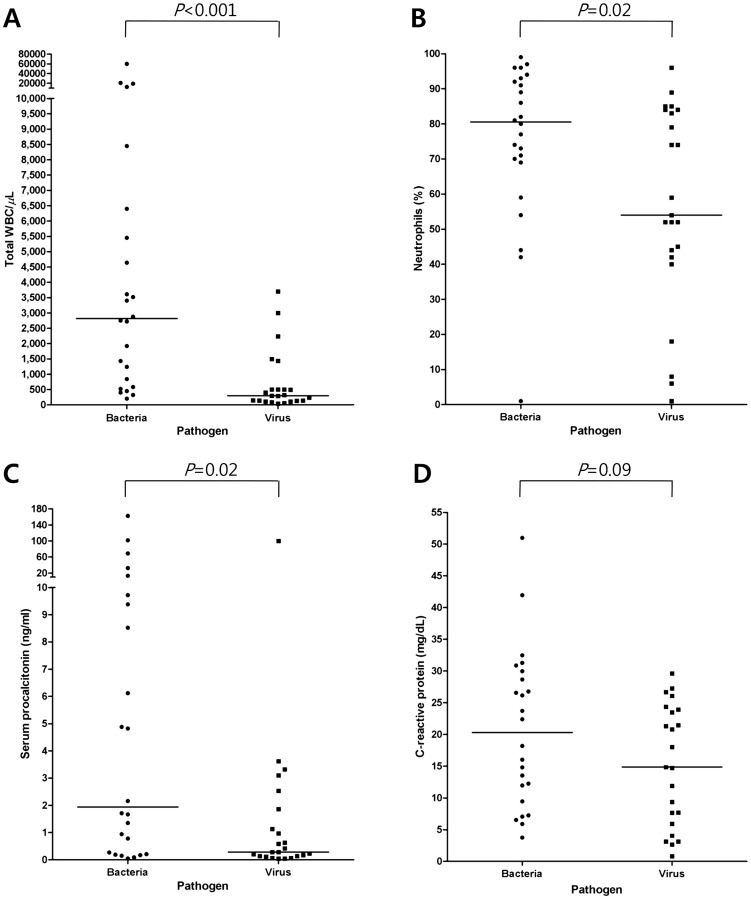
Distributions of bronchoalveolar lavage (BAL) fluid total white blood cell (WBC) count, BAL fluid percentage of neutrophils, serum procalcitonin concentration, and serum C-reactive protein concentration.
(A) total WBC count in BAL fluid, (B) percentage of neutrophils in BAL fluid, (C) serum procalcitonin concentration, and (D) serum C-reactive protein concentration. Horizontal bars indicate median values.